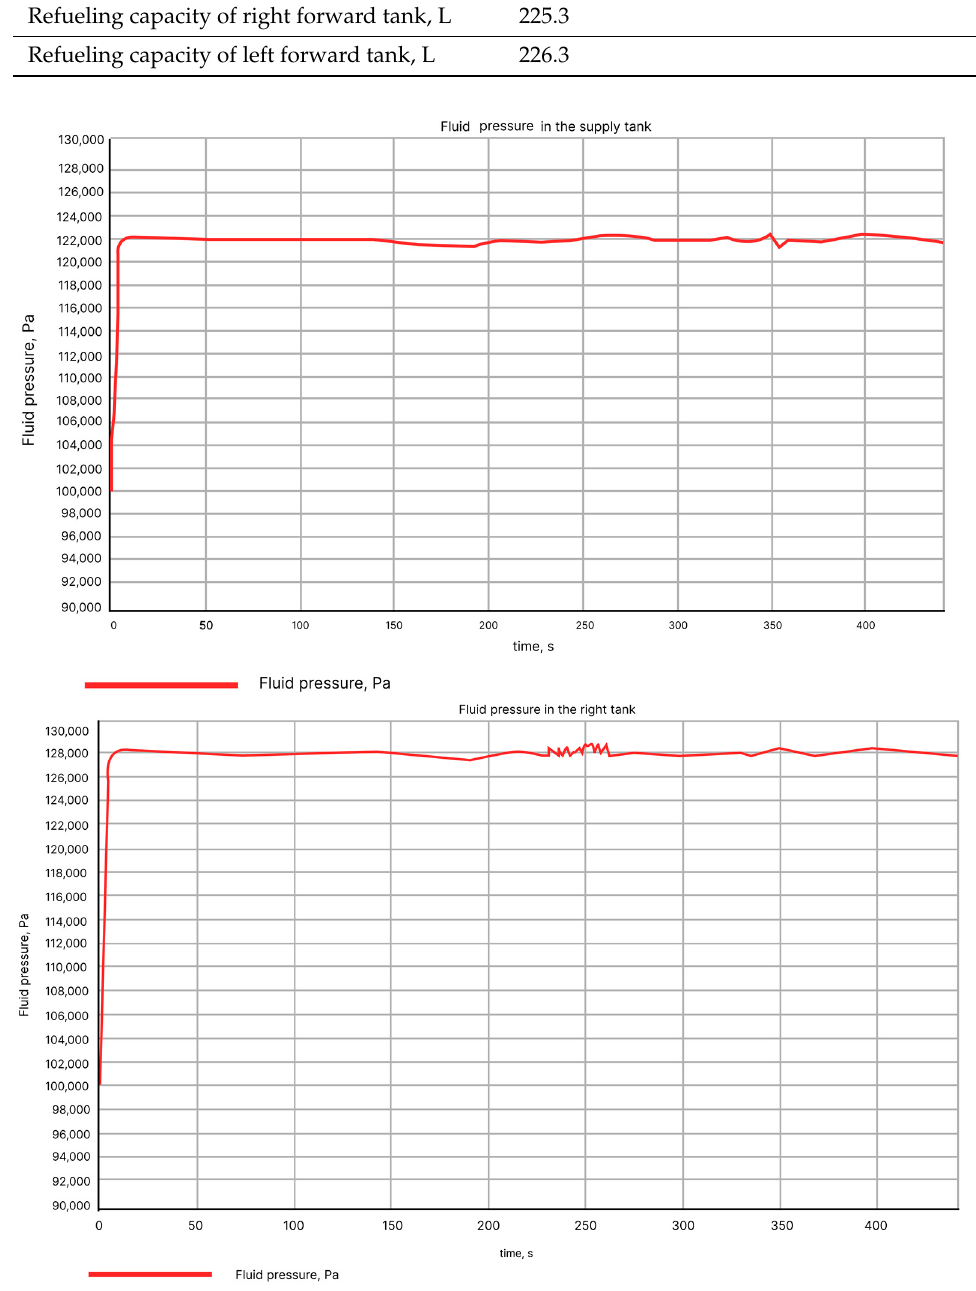
Figure 6. Fluid pressure in tanks during refueling.